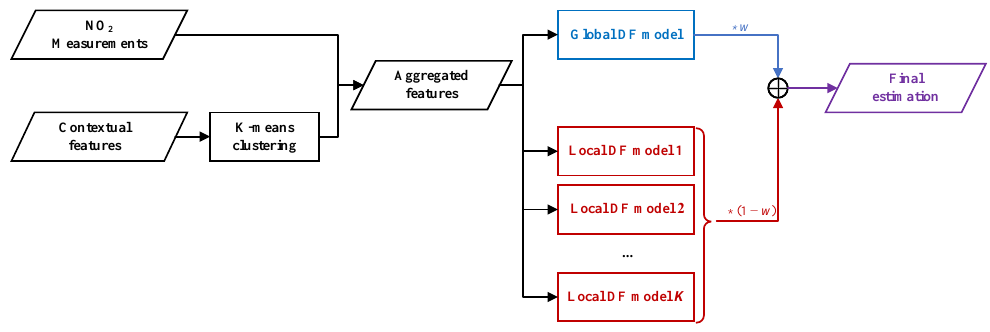
Figure 10. The workflow of proposed CLADF